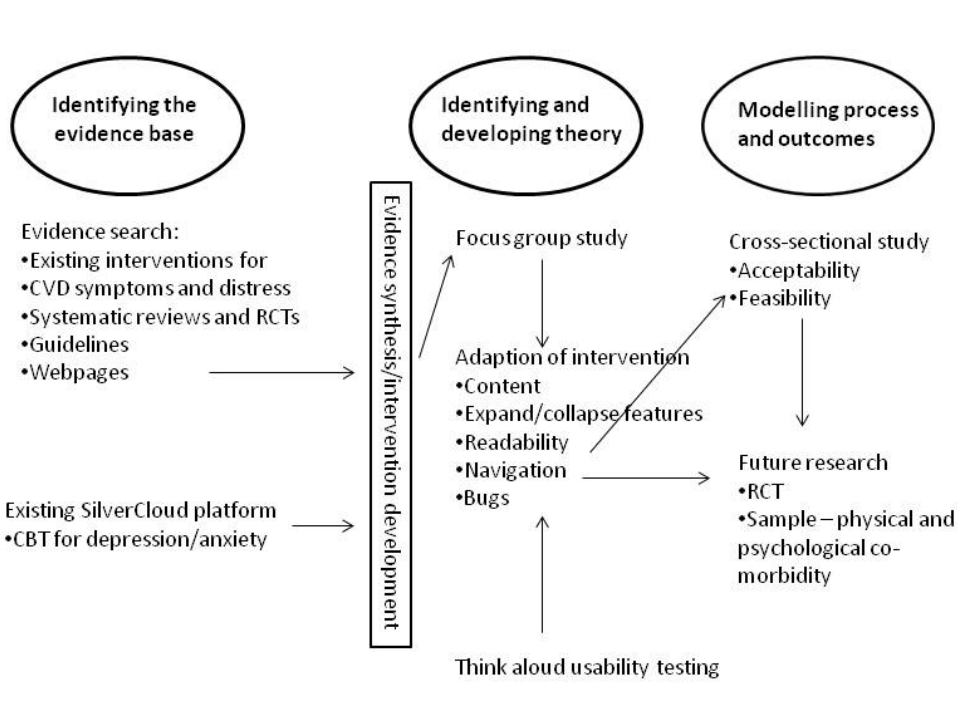
Figure 1. Medical Research Council development stage of Space from Heart